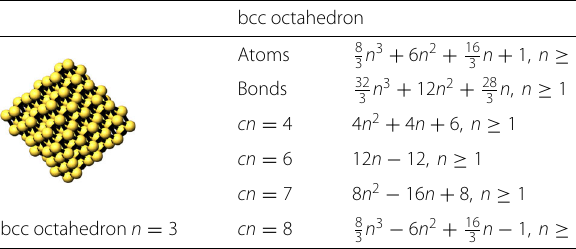
Table 3 Magic formulas for the bcc octahedron